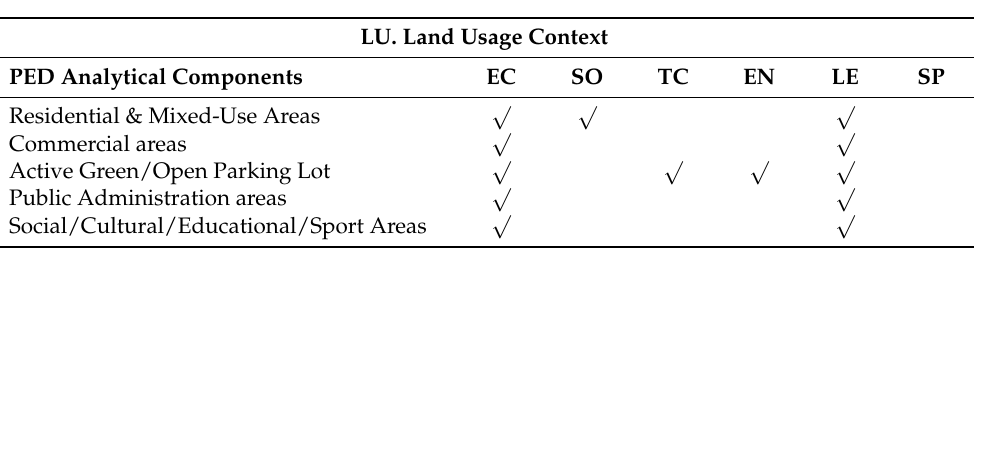
Table 9. Criteria considered for Land Usage PED analytical components